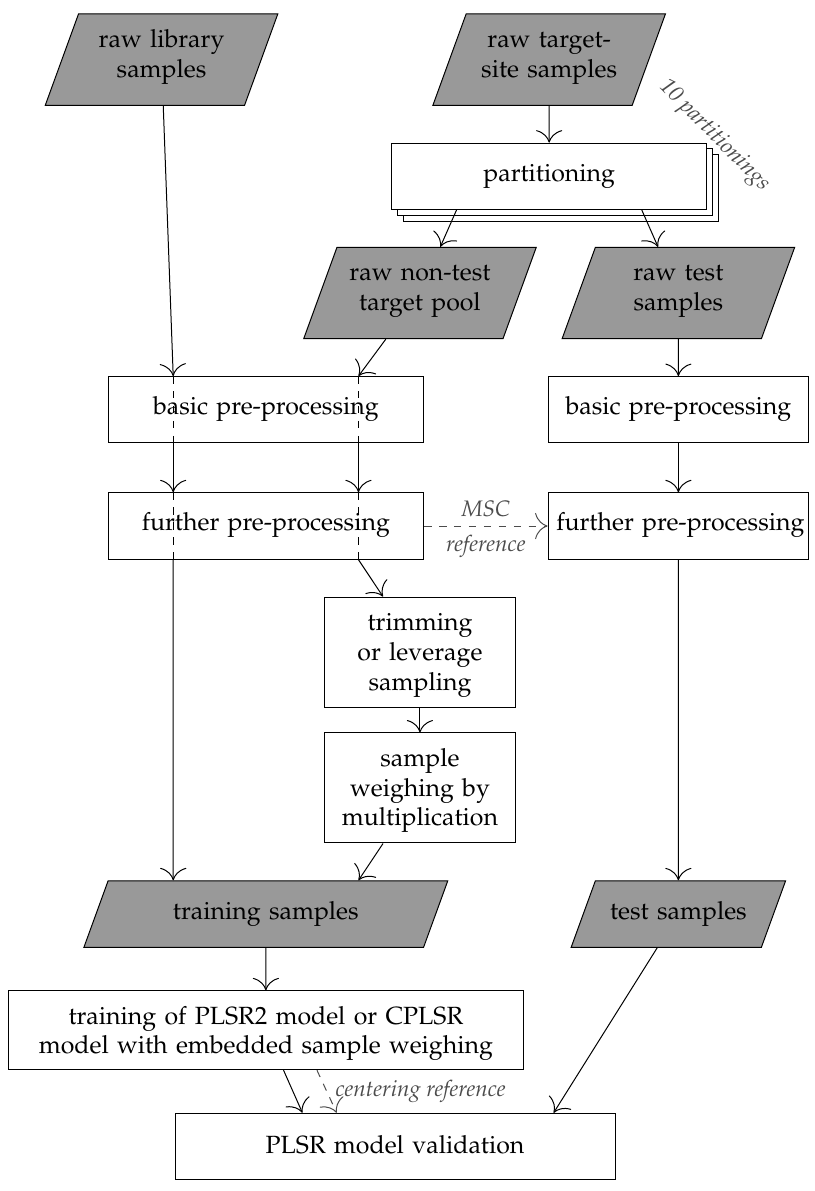
Figure 2. Data processing